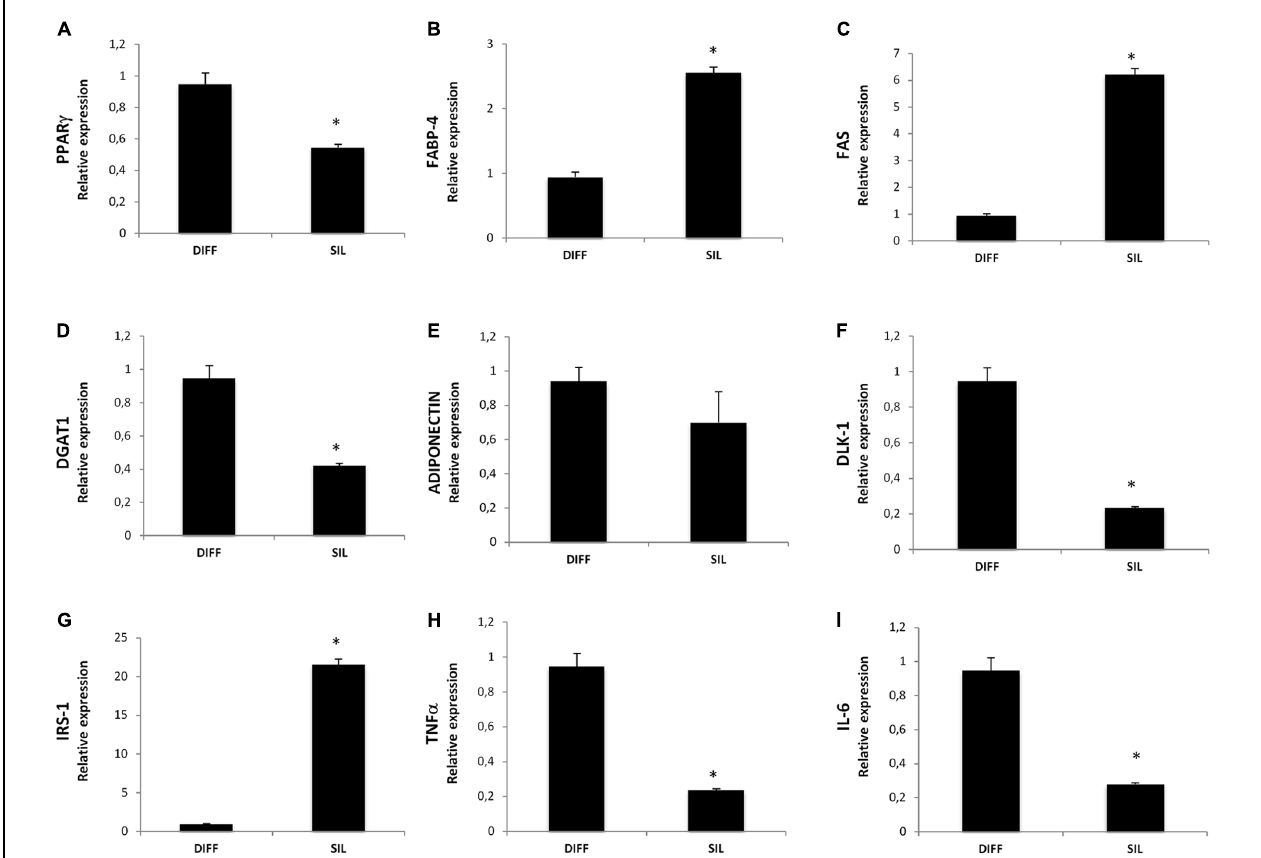
FIGURE 5 | Analysis of gene expression, evaluated by Real Time PCR, of cells treated with silibinin for 24 h after adipogenic differentiation. Each graph (A–I) represents the relative expression of a single gene indicated on the Y axis compared to differentiated untreated cells. All values are expressed as mean ± SEM of four experiments ( n = 4) in duplicate. ∗ P < 0.05 vs.